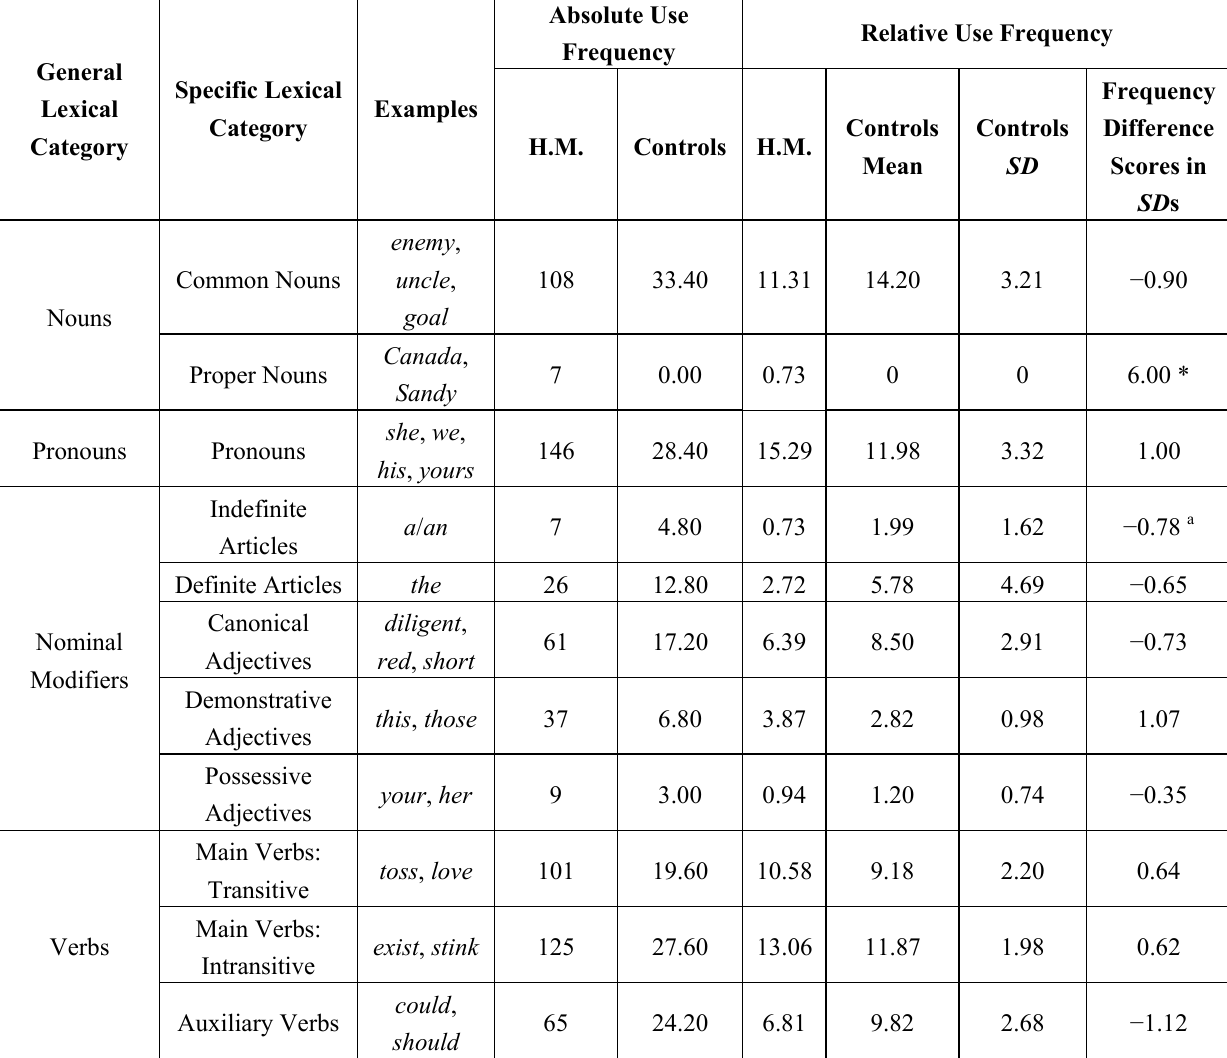
Table 2. Absolute and relative use frequency of lexical categories for all words in Study